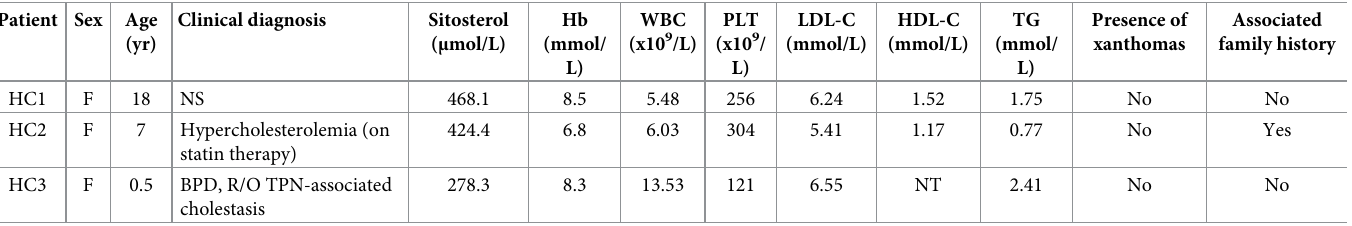
Table 4. Additional data of three overtly hypersitosterolemic